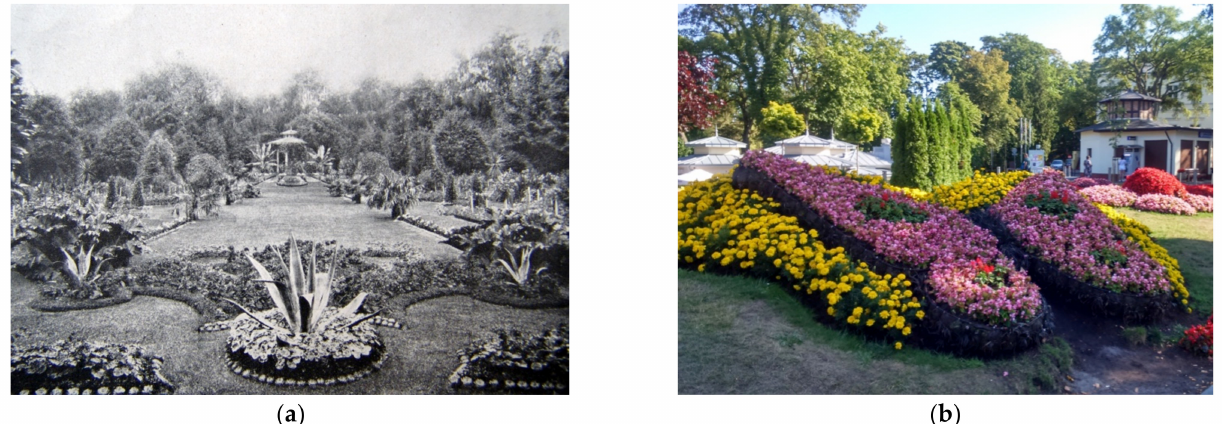
Figure 4. Surface elements: ( a ) Kołobrzeg Spa Park—the beginning of the 20th century, ( b ) Mi˛edzyzdroje Spa Park—2018. Source: Motzke P.; Deutschlands Stadtebau . Kolberg, Berlin-Halensee: “Dari” Verlag, 1921 ( a ), Author’s photo ( b ).